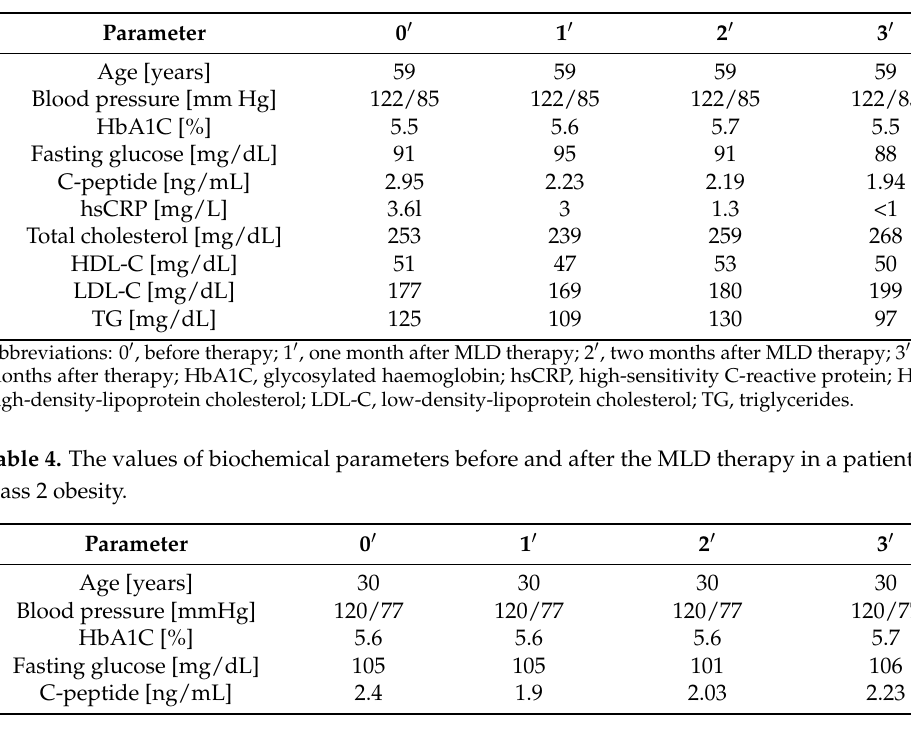
Figure 5. Abdominal deep drainage: on the naval ( a ); parallel to the left costal arch ( b ); parallel to the left inguinal ligament ( c ); parallel to the left costal arch ( d ); on the naval ( e ); parallel to the right costal arch ( f ); parallel to the right inguinal ligament ( g ); parallel to the right costal arch ( h ); on the naval ( i ); conclusion effleurage with breathing. Table 3. The results of biochemical parameters before and after the MLD therapy in an overweight patient.